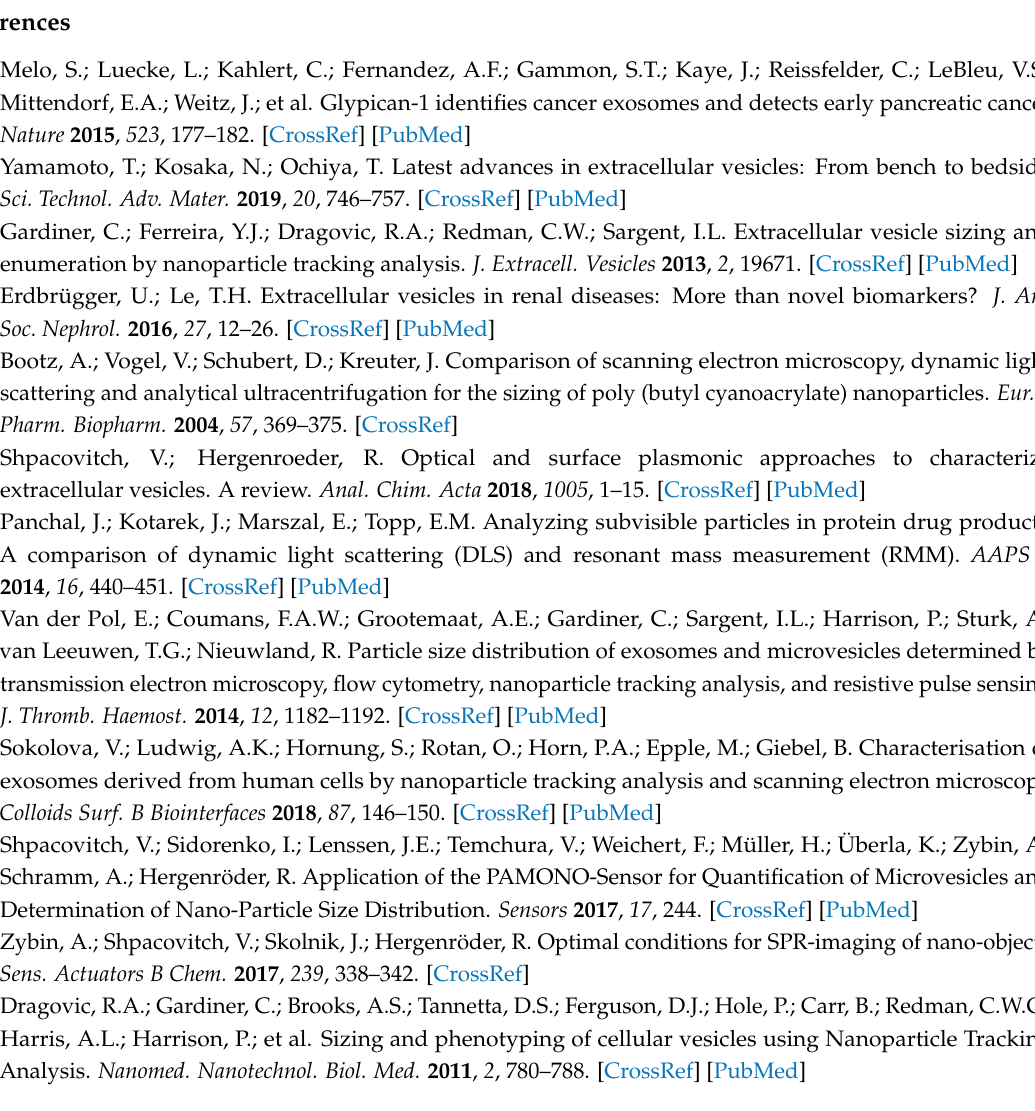
Figure A2. SEM images of the measured polystyrene nanoparticle samples of different sizes. ( A ) 100 nm polystyrene nanoparticles, ( B ) 200 nm polystyrene nanoparticles, ( C ) 300 nm polystyrene nanoparticles, and ( D ) 400 nm polystyrene